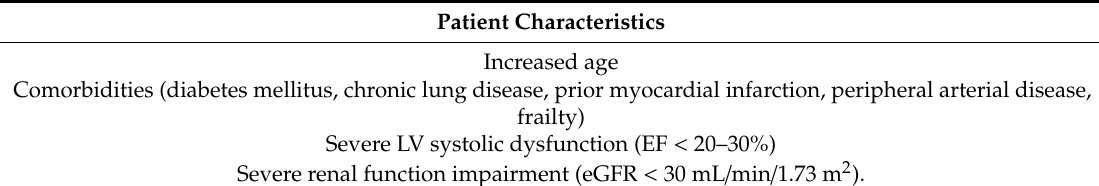
Table 1. High-Risk Percutaneous Coronary Intervention